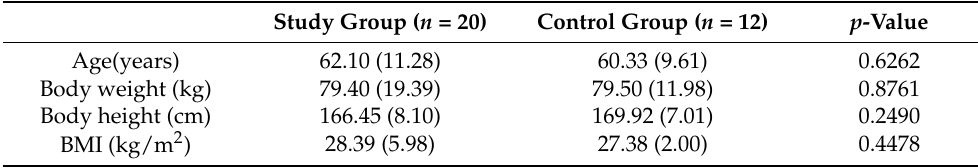
Table 1. Participants’ anthropometric characteristics (mean (SD)).